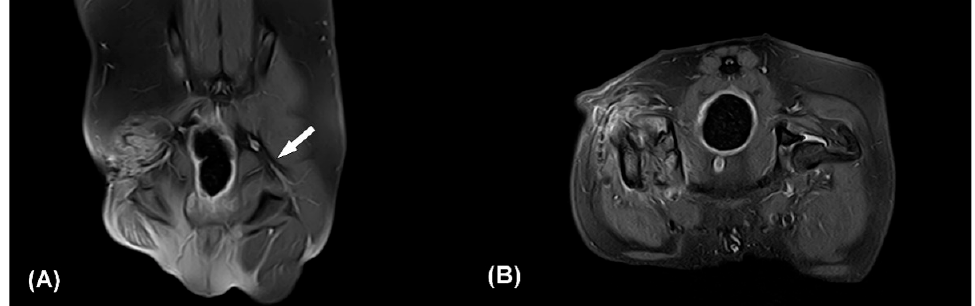
Figure 2. Contrast enhanced fat-suppressed proton density weight images (CE-FS-PDWI) of dorsal ( A ) and transverse plane ( B ). The white arrow indicates the intact left sciatic nerve ( A ). The right sciatic nerve strand is not clearly identifiable ( A , B ). Note that focal discontinuity of the sciatic nerve, muscle fibrosis, and edema of surrounding soft tissue. Q: quadriceps muscle, Bi: biceps femoris